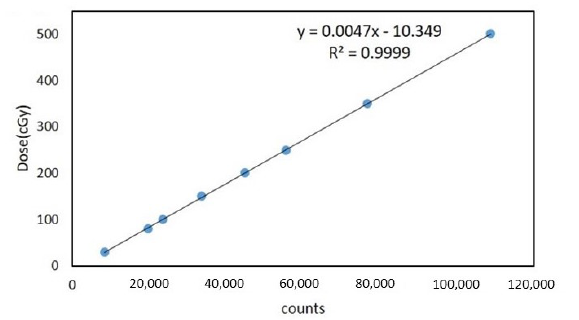
Figure 1. A TLD calibration curve is generated by irradiating a dose range of 30–500 cGy.